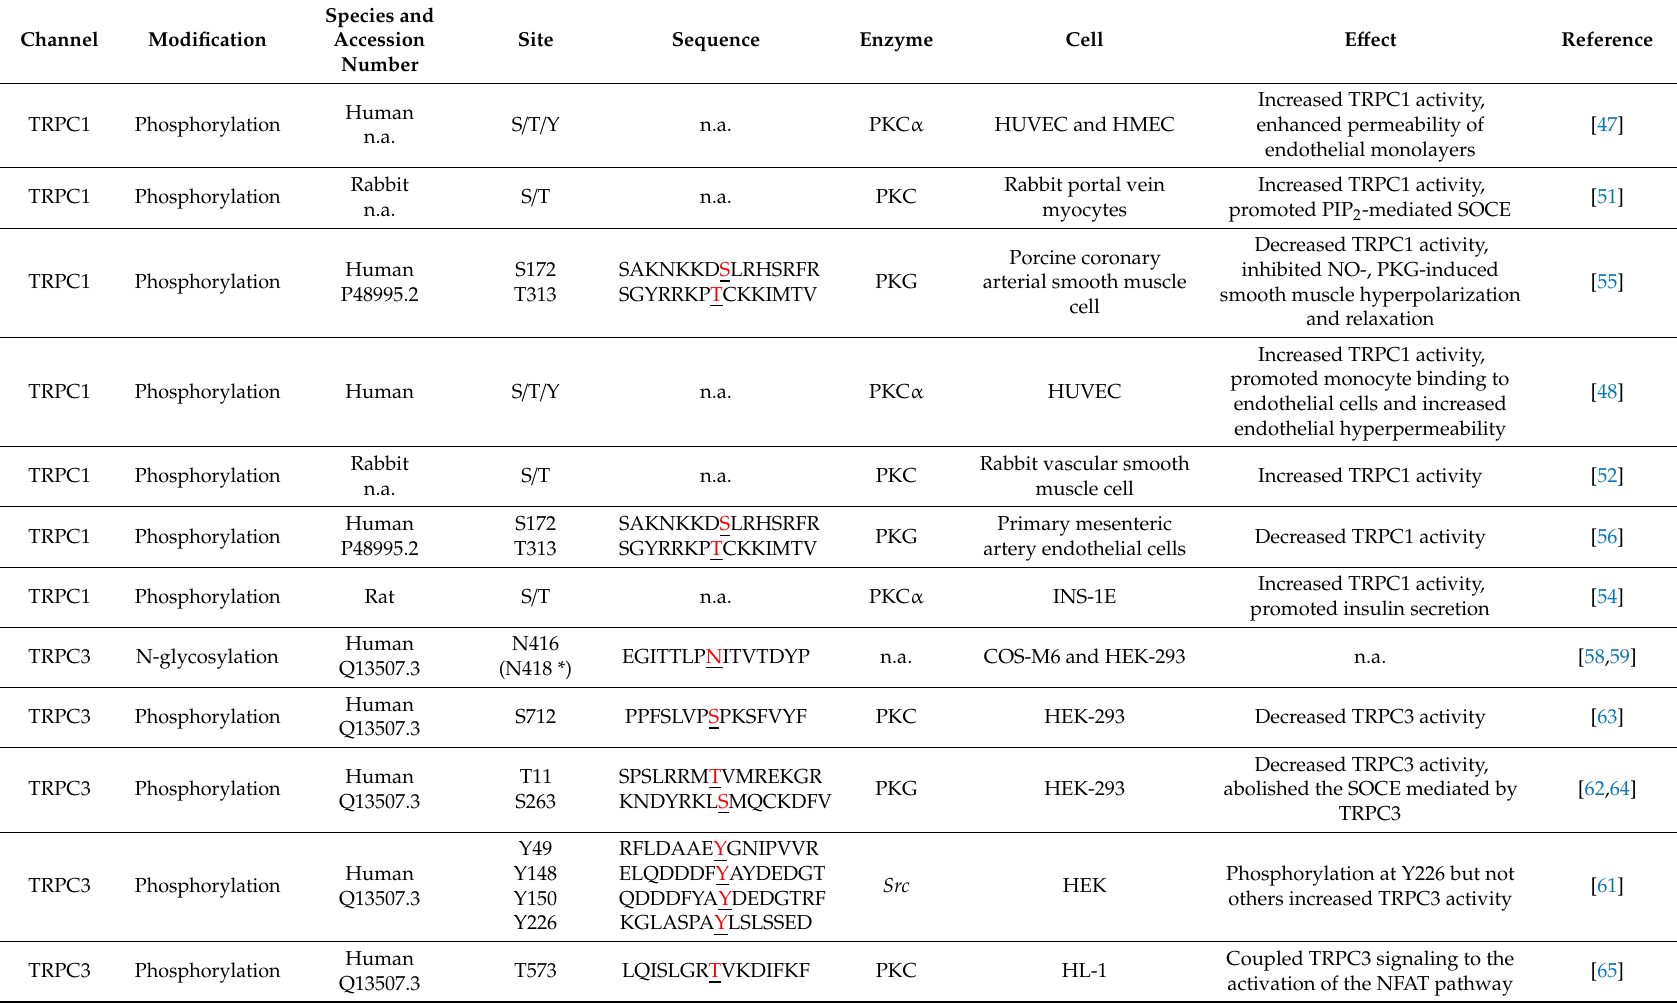
Table 1. PTMs of di ff erent members of TRPC as reported by traditional experimental